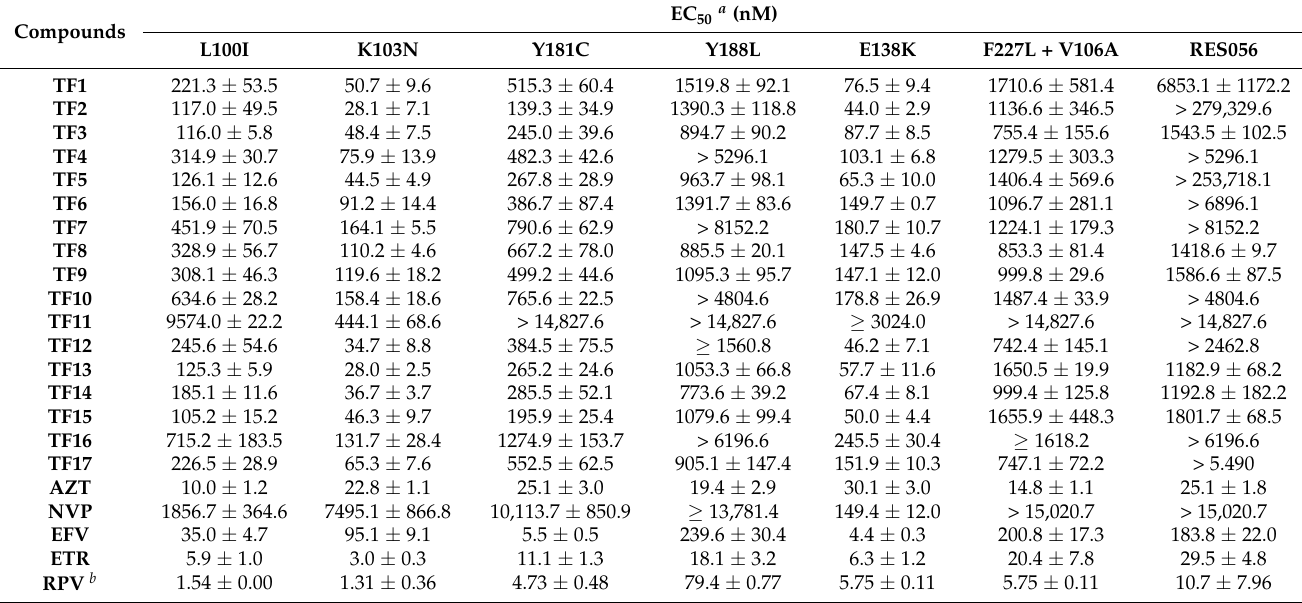
Table 2. The activity of anti-HIV-1 mutant strains of TF1–17